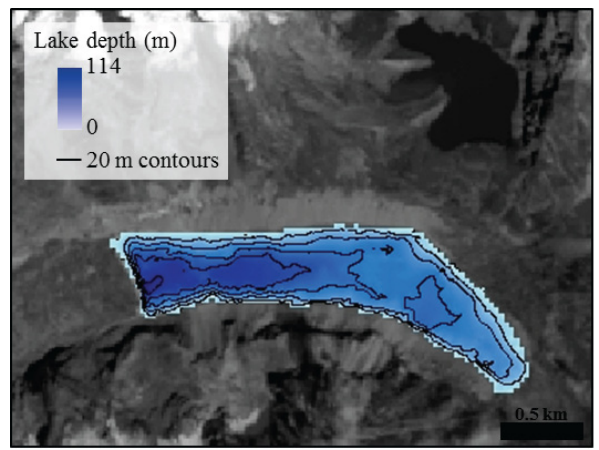
Figure 8. Bathymetric survey conducted on Lumding Tsho on 22– 23 October 2015.